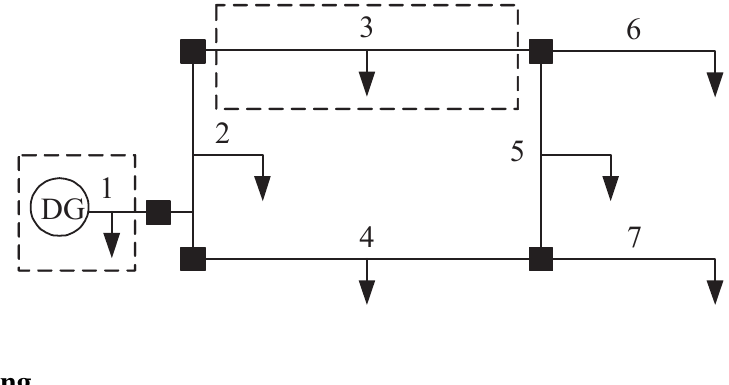
Figure 2. An islanded microgrid one-distributed generation (DG) microsource [32].